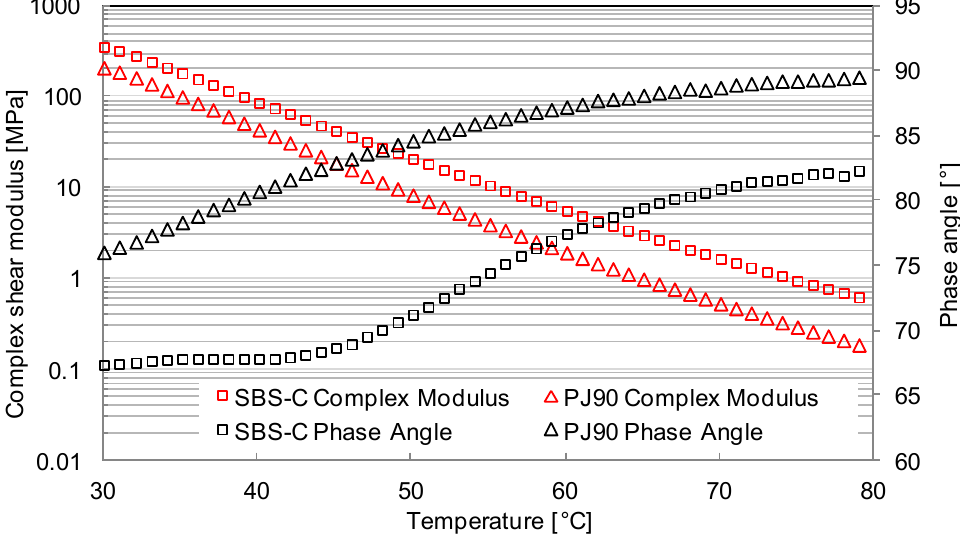
Figure 9. Phase angle and modulus curves at the higher temperature